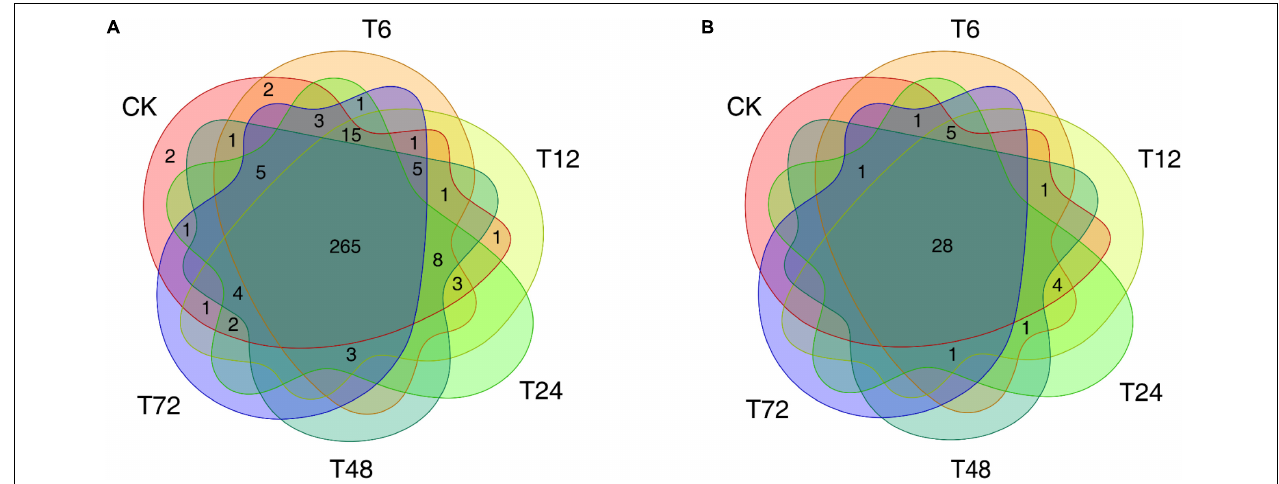
FIGURE 1 | The distribution of miRNAs in six sugarcane root samples. (A) The distribution of the known miRNAs. (B) The distribution of the novel miRNAs. CK, T6, T12, T24, T48, and T72 correspond to 0, 6, 12, 24, 48, and 72 h after low-K + treatment, respectively.